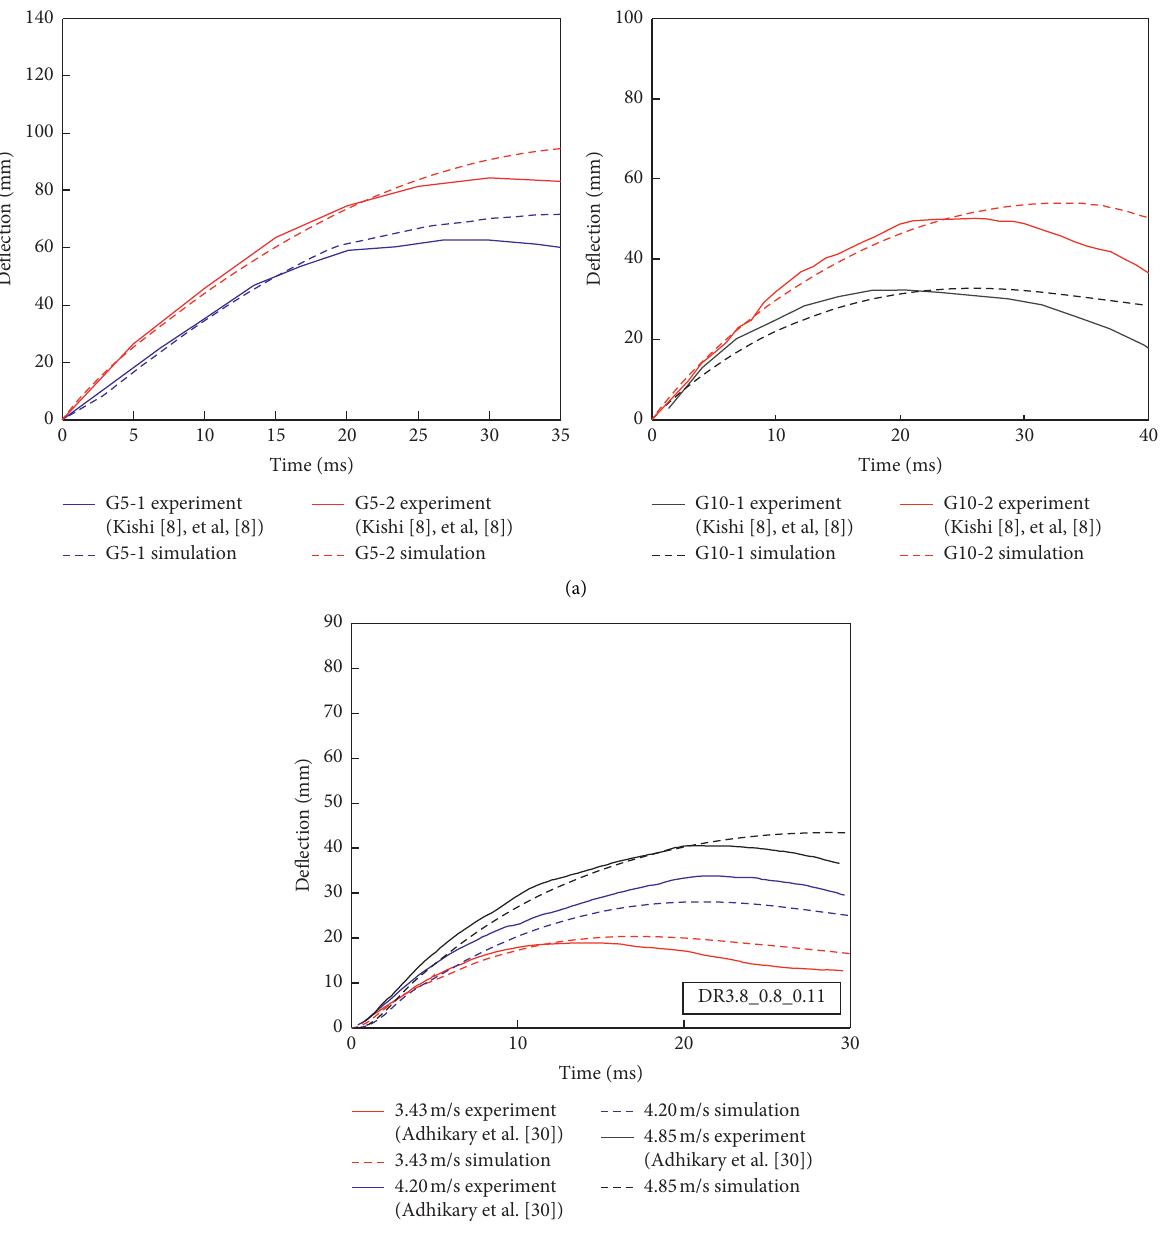
Figure 9: Comparison of the midspan deflection time histories for RC beams between the simulation and experiments. (a) Kishi’s ex- periments. (b) Adhikary et al.’s